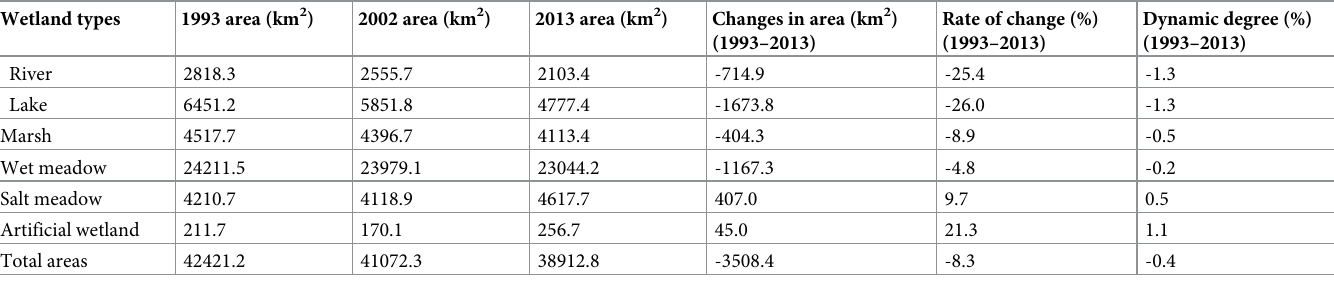
Table 2. Dynamic changes in wetland area of Inner Mongolia during 1993–2013.